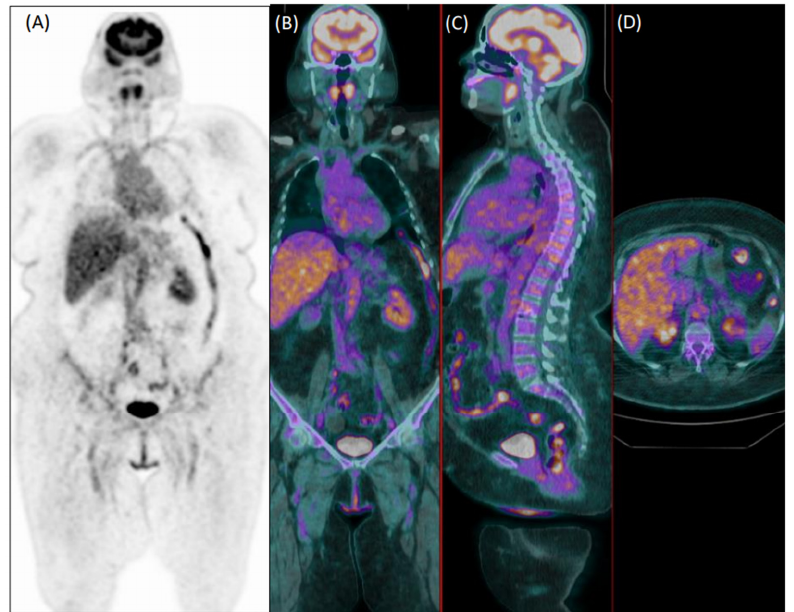
Figure 2. Coronal [ 18 F]FDG PET ( A ) and fused PET/CT coronal ( B ), sagittal ( C ), and axial ( D ) images of a 75-year-old female patient with diffuse articular pain and suspicion of vasculitis, not further confirmed during clinical follow-up. Images were evaluated as positive for increased uptake in the aorta, and both subclavian and iliac arteries by the experienced reader 1. Reader 2 evaluated the exam as negative.